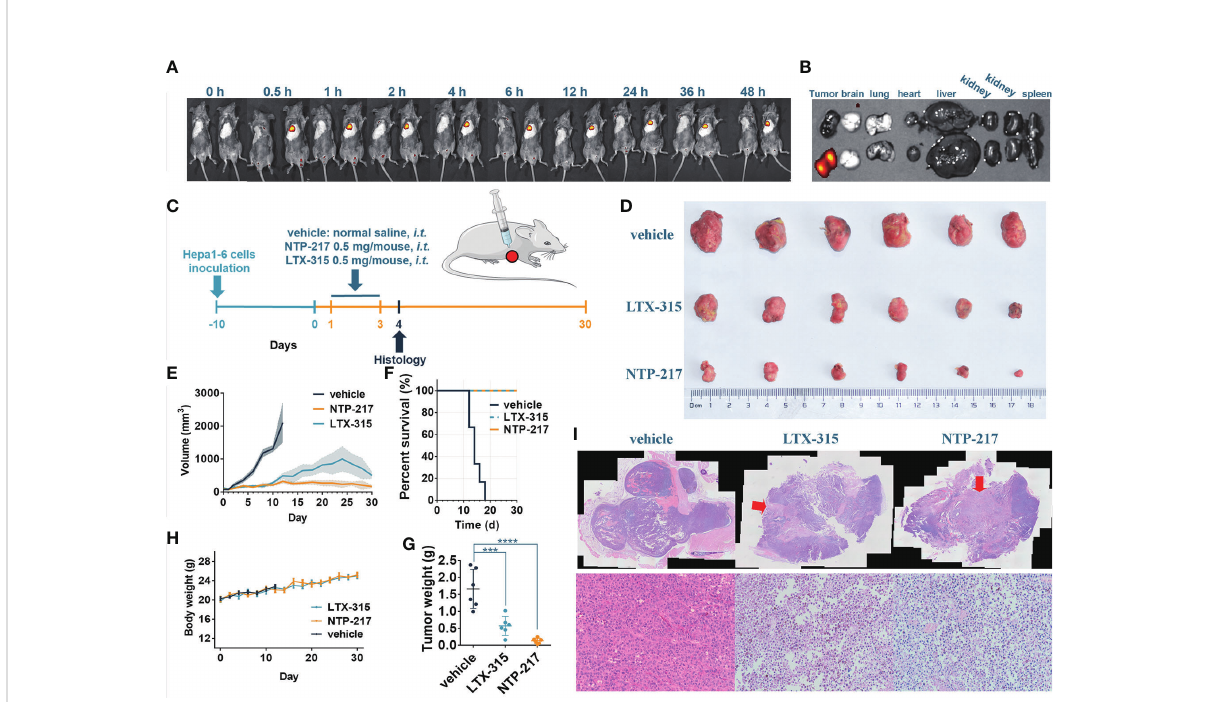
FIGURE 2 NTP-217 stably accumulates in tumor tissue and inhibits tumor growth. (A) In vivo fl uorescence images of mice with Hepa 1-6 tumors were obtained at different times after intralesional injection (50 m l of 10 mg/ml) of (left) LTX-315 or (right) NTP-217. (B) Fluorescence images of the tumor and main organs of Hepa 1-6 tumor-bearing mice at 48 h post-injection of (top) LTX-315 or (bottom) NTP-217. (C) Schematic illustration of the timeline required for the therapeutic experiments. (D) Images of excised Hepa 1-6 tumors. (E) Tumor growth kinetics of different groups. mean ± SEM. (F) Survival analysis of Hepa 1-6 tumor-bearing mice. (G) Weight of Hepa 1-6 tumors. mean ± SD. ***P<0.001, ****P<0.0001. (H) Body weight of different groups. mean ± SD. (I) Representative (top) hematoxylin and eosin staining (objective magni fi cation, x4) and (bottom) enlargement of the injection area (objective magni fi cation, x10). The arrow indicates the injection area of oncolytic peptides. i.t. : intralesional